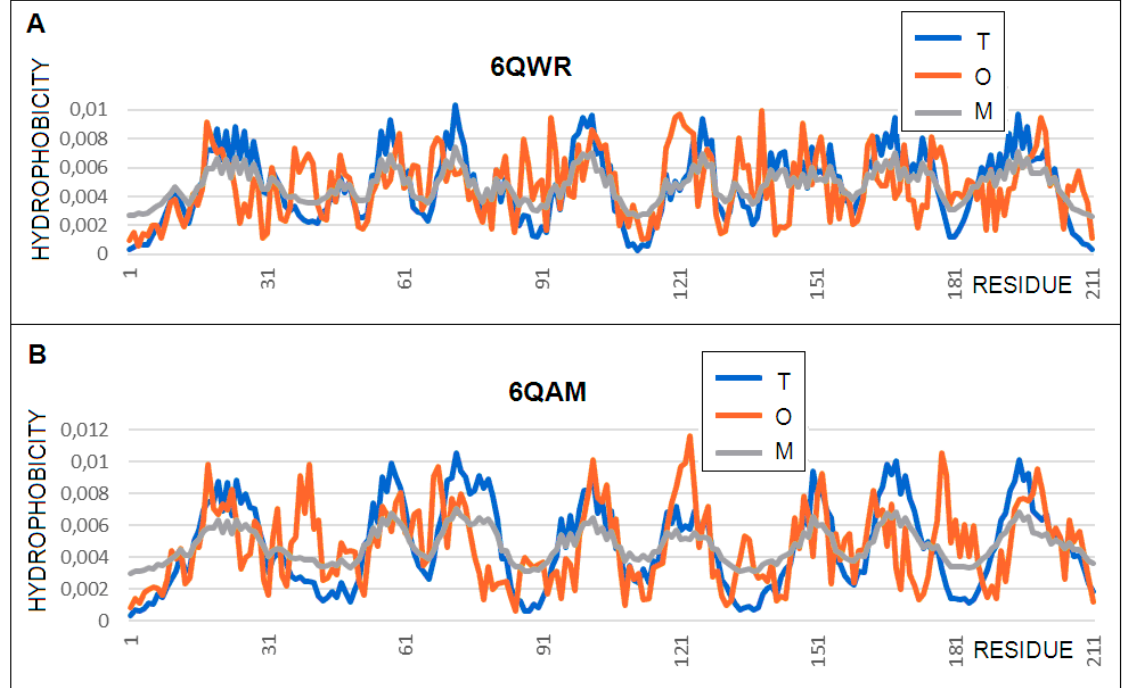
Figure 4. Profiles T (blue), O (red), and M (gray) for: ( A ) the 6QWR–lipid. Profile M for K = 0.4 and ( B ) 6QAM detergent. Profile M for K = 0.5.